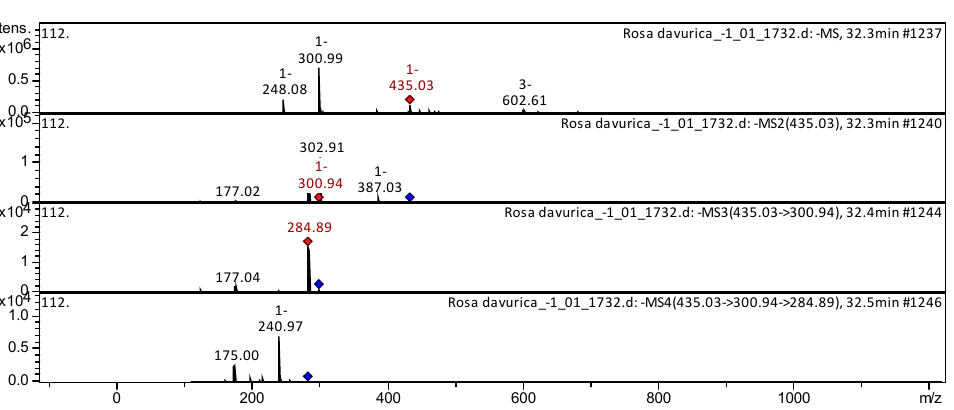
Figure 8. CID-spectrum of Taxifolin- O -pentoside from extracts of R. davurica , m / z 285.03. The [M − H] − ion produced three fragment ions at m / z 387, m / z 300, and m / z 177 (Fig- ure 8). The fragment ion with m / z 300 yielded two daughter ions at m / z 284 and m / z 177. The fragment ion with m / z 284 yielded two daughter ions at m / z 240 and m / z 175. It was identified in the bibliography in extracts of millet grains [23] and A. cordifolia [25].